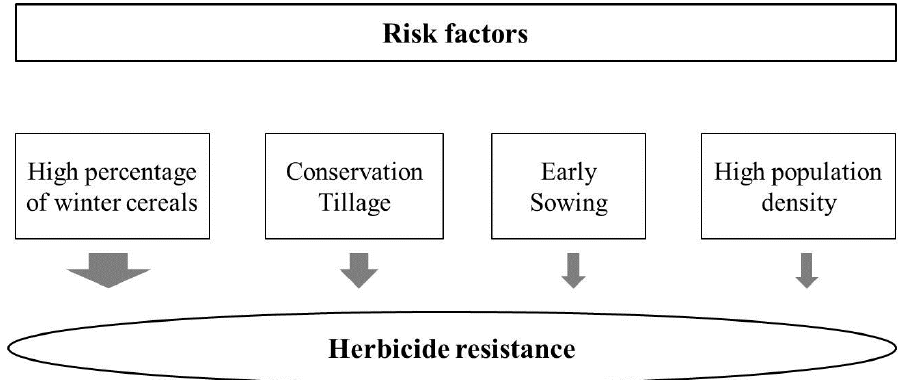
Figure 2. Flow chart showing the risk factors involved in the development of herbicide resistance. All factors, with the exception of soil texture, significantly increased the probability of resistance occurrence in A. spica-venti . The size of the arrows is proportional to the significance of each